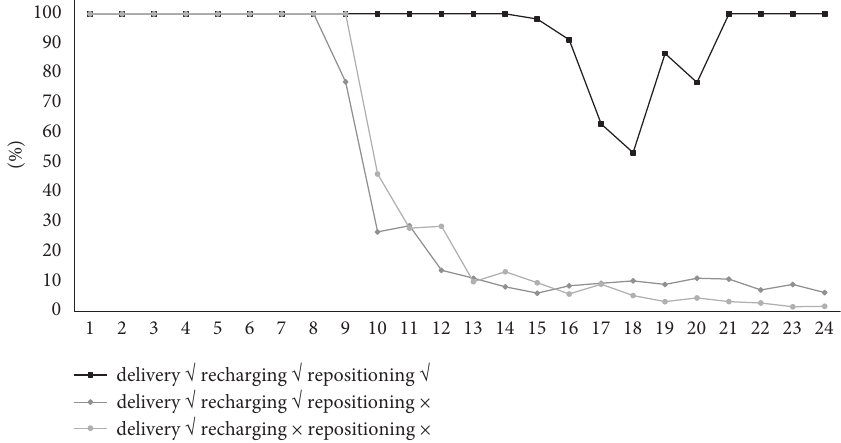
Figure 11: Order fulfillment of assignment process considering different tasks.